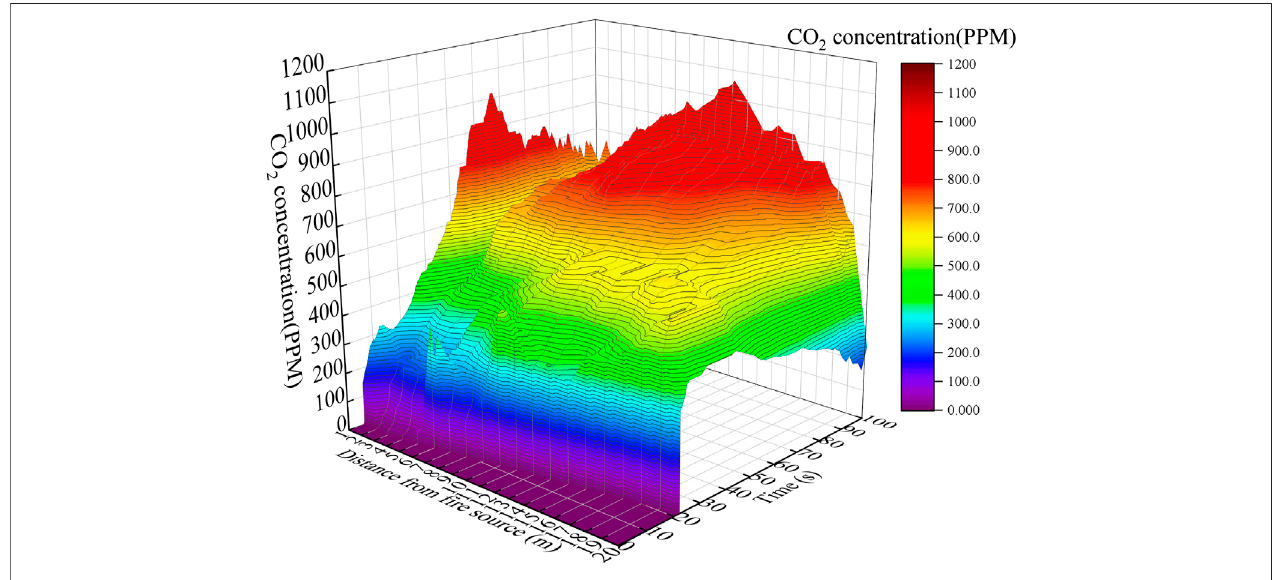
FIGURE 6 | Variation curve of CO 2 concentration ( fi re source power 600 kW).